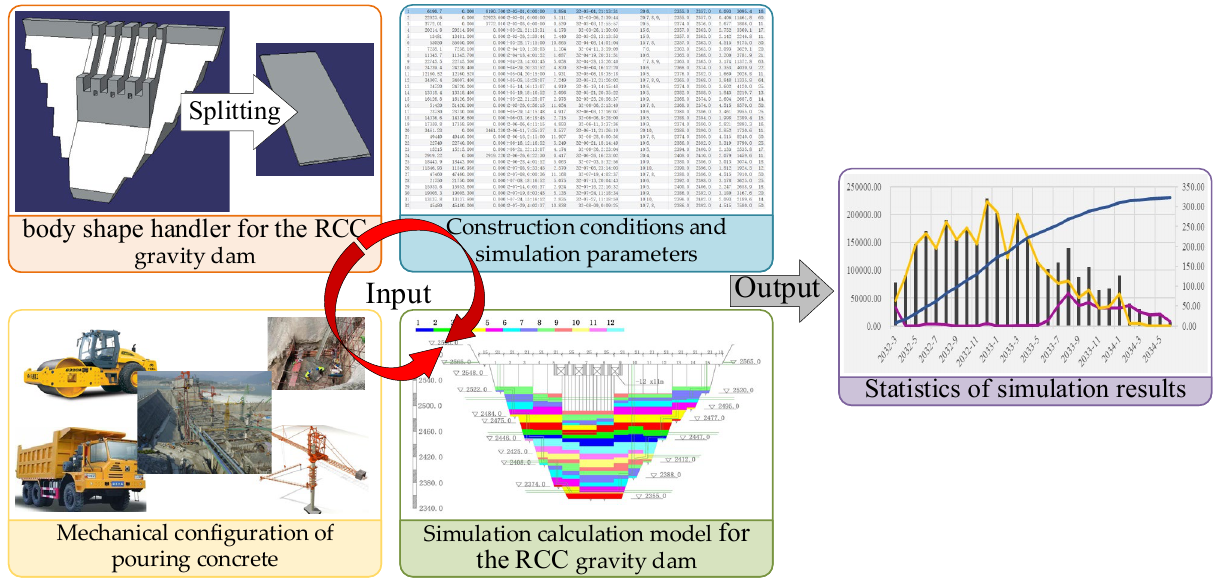
Figure 4. Framework of the RCC gravity dam construction progress simulation system.